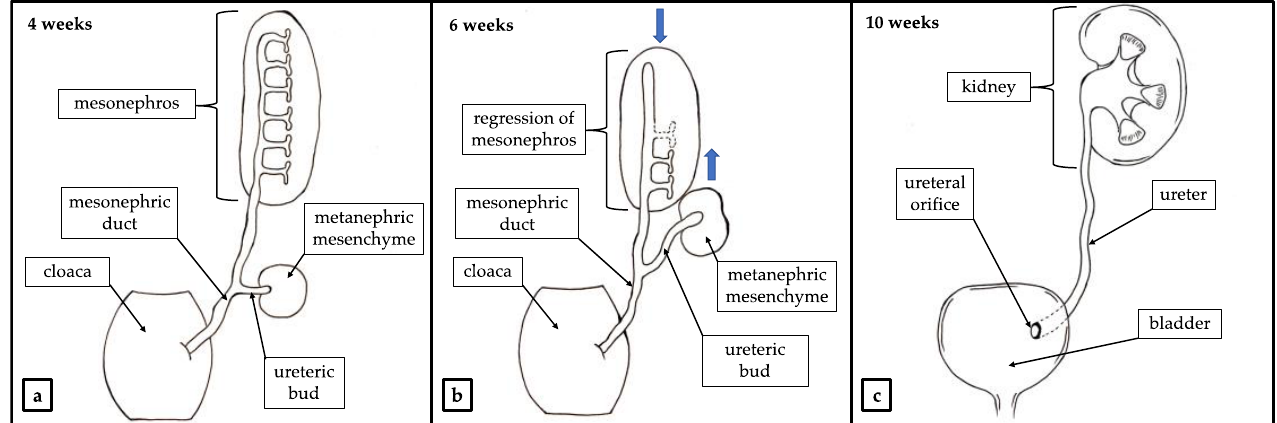
Figure 2. Physiological development of renal system. ( a ) Outgrowth of ureteric bud. ( b ) The metanephric mesenchyme and the ureteric bud migrate cranially toward the final localization of the permanent kidney. Mesonephros atrophies and degenerates. Mesonephric duct migrates caudally and acquires reproductive function [4]. Movement of the structures indicated with blue arrows. ( c ) Developed urinary system.